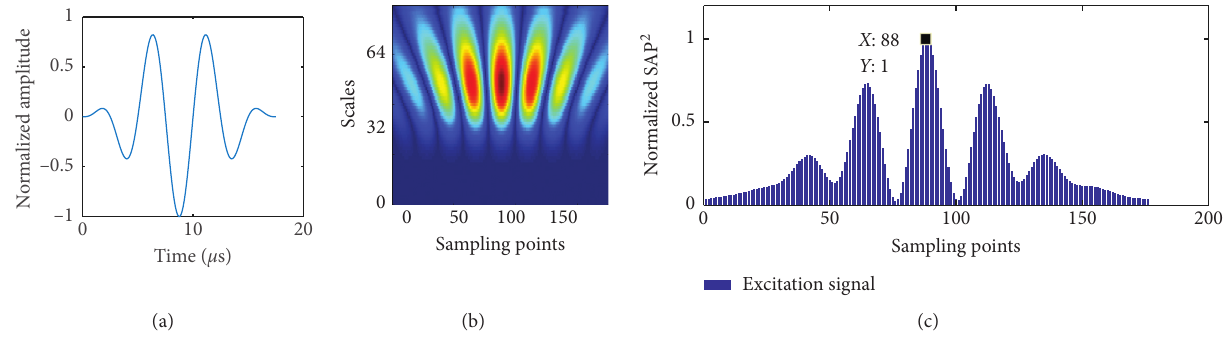
Figure 4: Procedure of SAP 2 : (a) excitation signal; (b) wavelet spectrum of (a); (c) SAP 2 of (a).